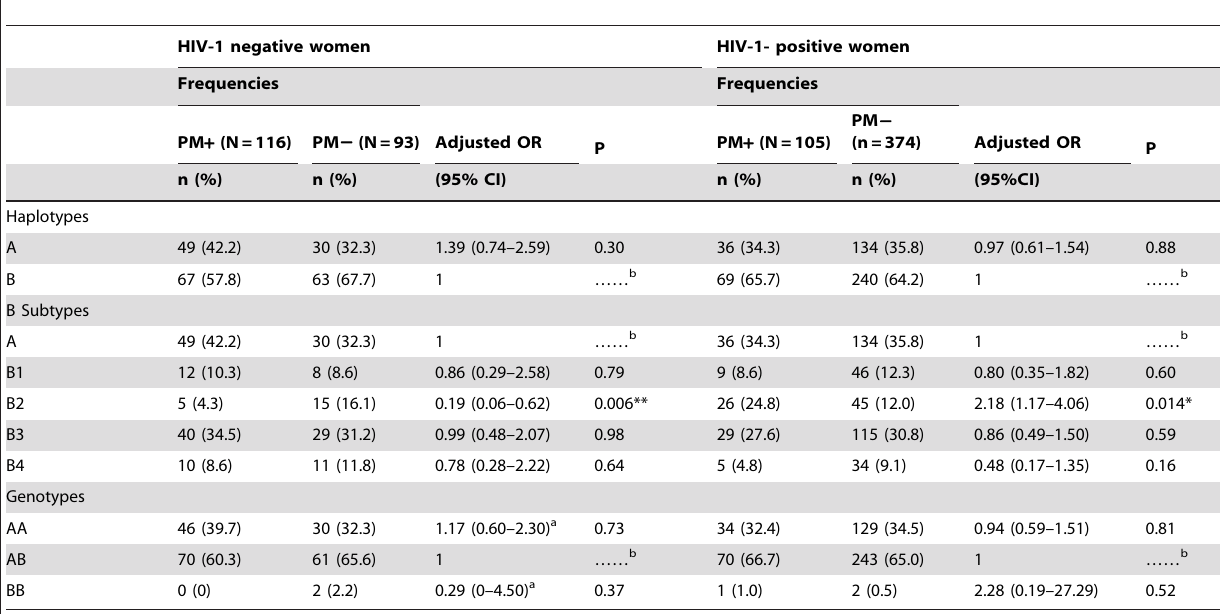
Table 3. Adjusted Odds ratios for KIR haplotypes, B subtypes and KIR genotypes in HIV-1 negative and HIV-1 positive women, outcome placental malaria (PM) status.